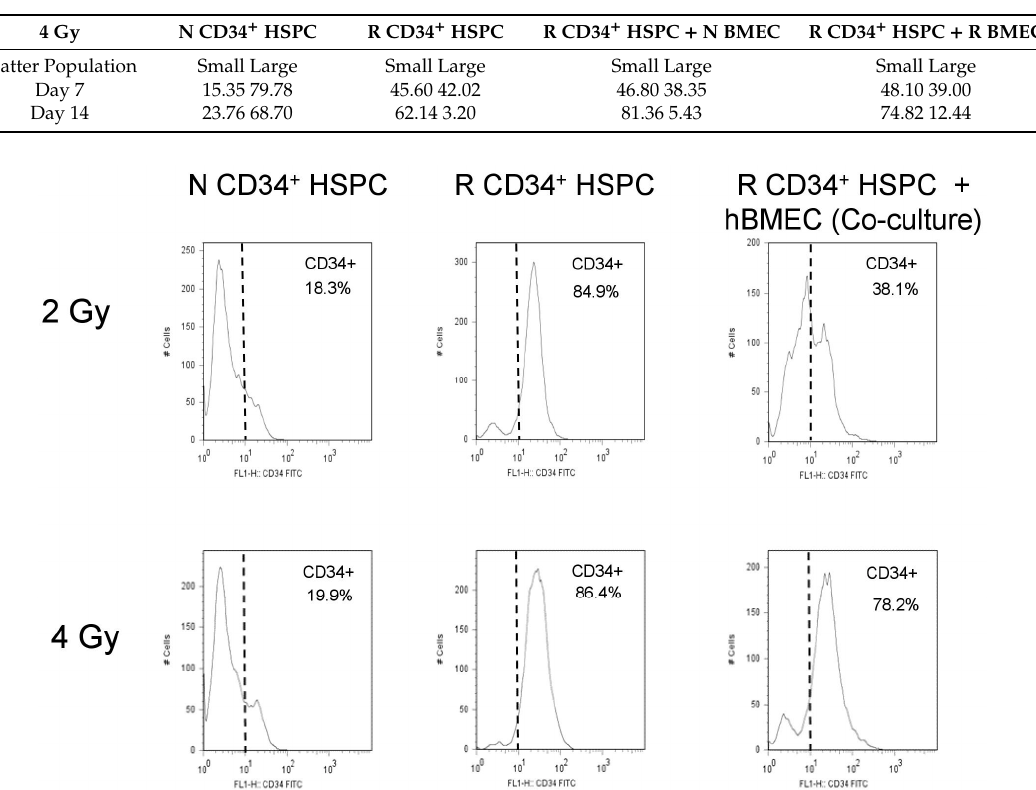
Table 2. CD34 + hSPC cell population percentages after 4 Gy MF radiation.